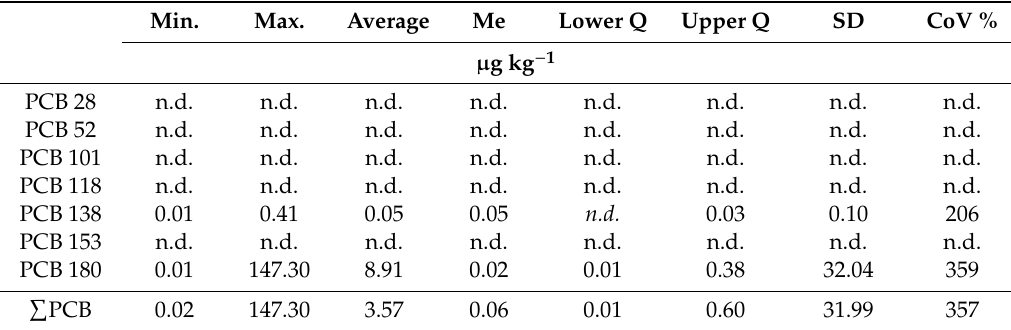
n.d.—notdefined,Min.—thelowestcontentofthetestcompound,abovethedetectionlimit,Max—thehighestcontent of the analyzed compounds, Me—median, Lower Q—lower quartile, Upper Q—upper quartile, SD—standard deviation, CoV—coe ffi cient of variation, and n—number of